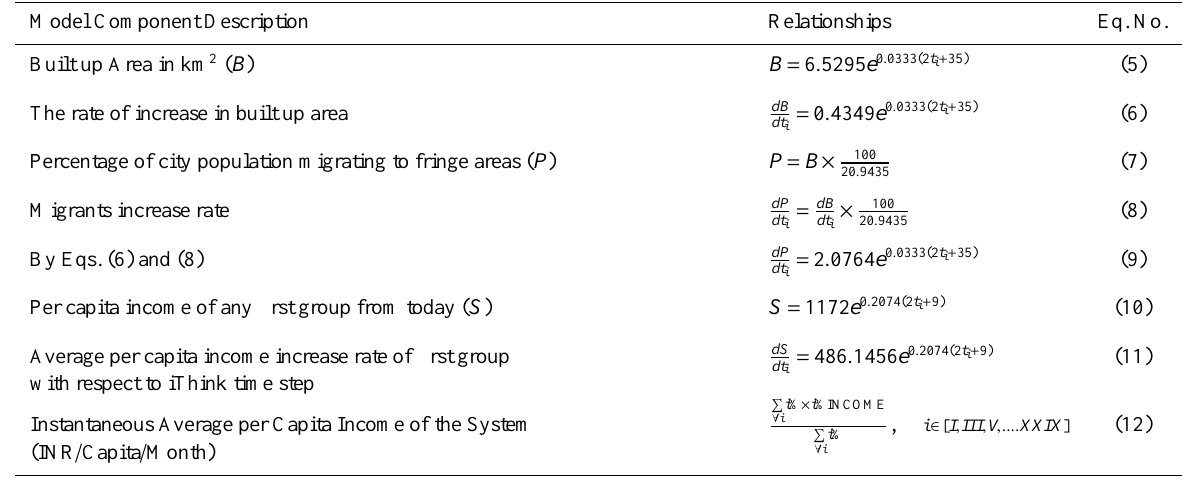
Table 9. Relationships in iThink model.